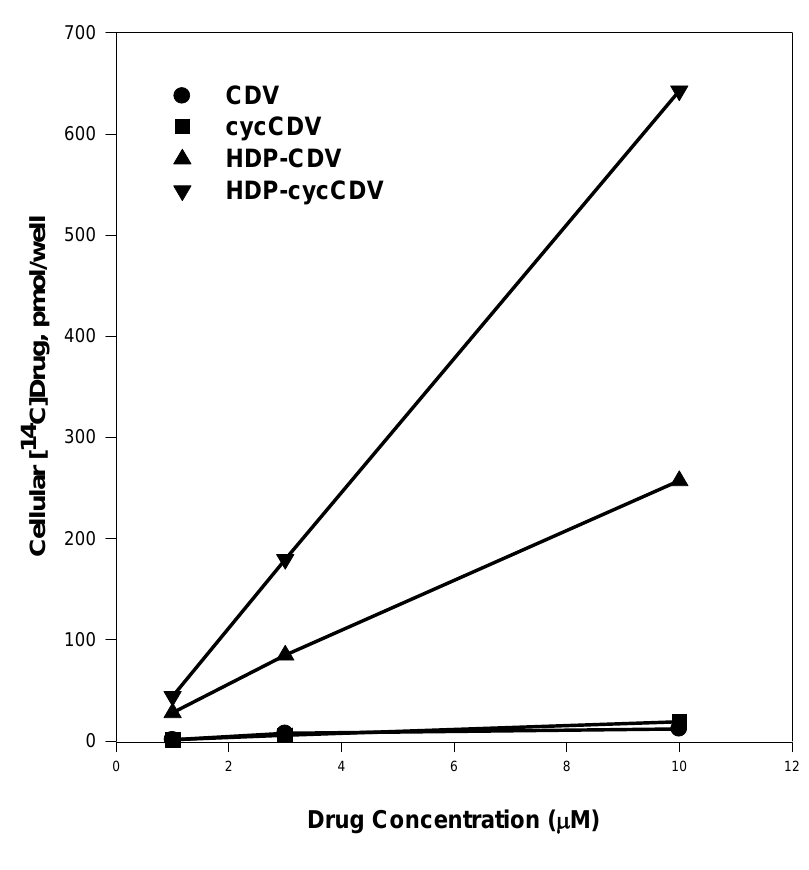
Figure 3. Uptake of 14 C-labeled CDV, cyclic-CDV, HDP-cyclic-CDV and HDP-CDV in MRC-5 Human Lung Fibroblasts. Adapted from Reference